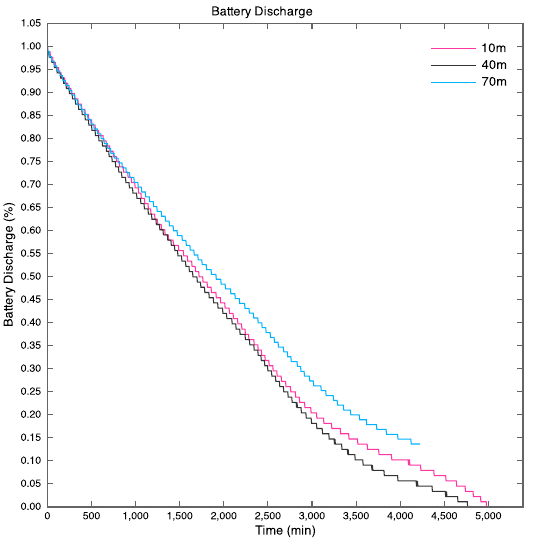
Figure 11. Battery discharge curves for Experiment 2.